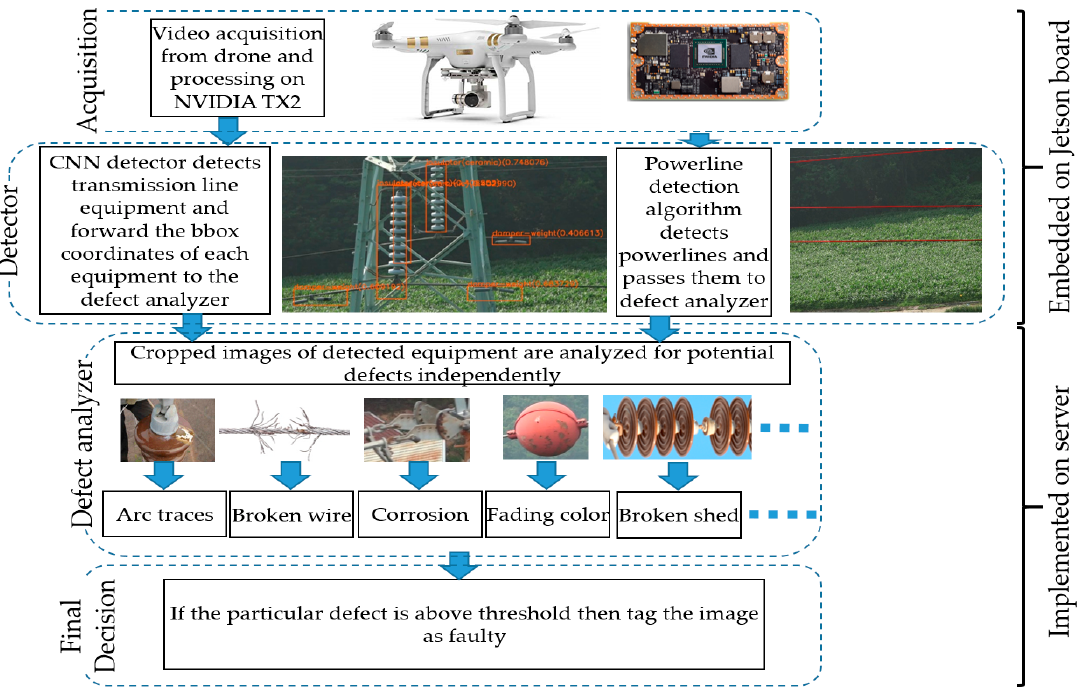
Figure 2. Overall system diagram.